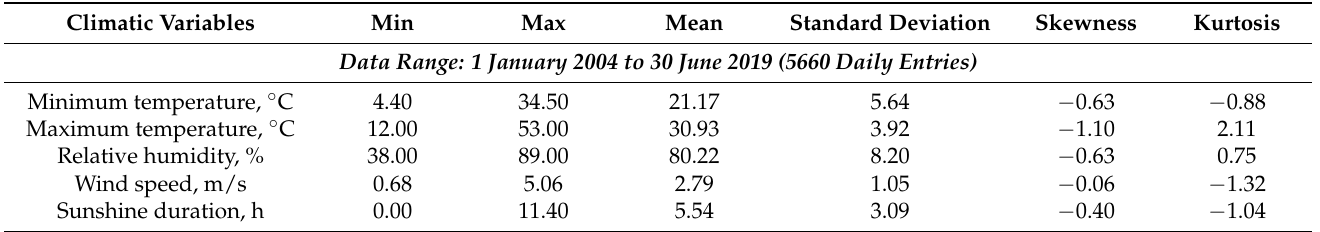
Table 1. Descriptive statistics of the weather data for the training station (Gazipur Sadar